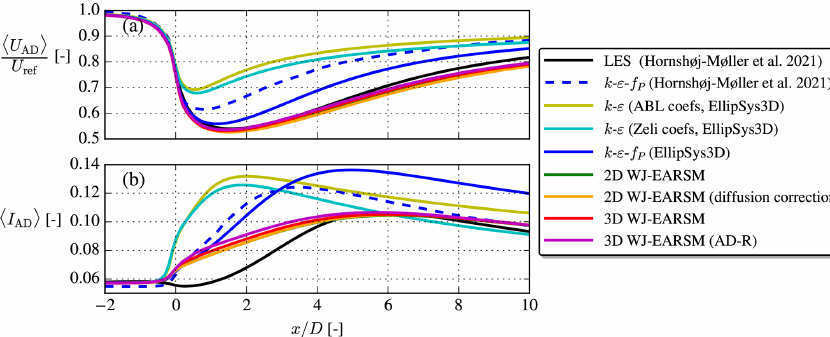
Figure 16. Disk-averaged streamwise velocity and TI for the single-wake V80